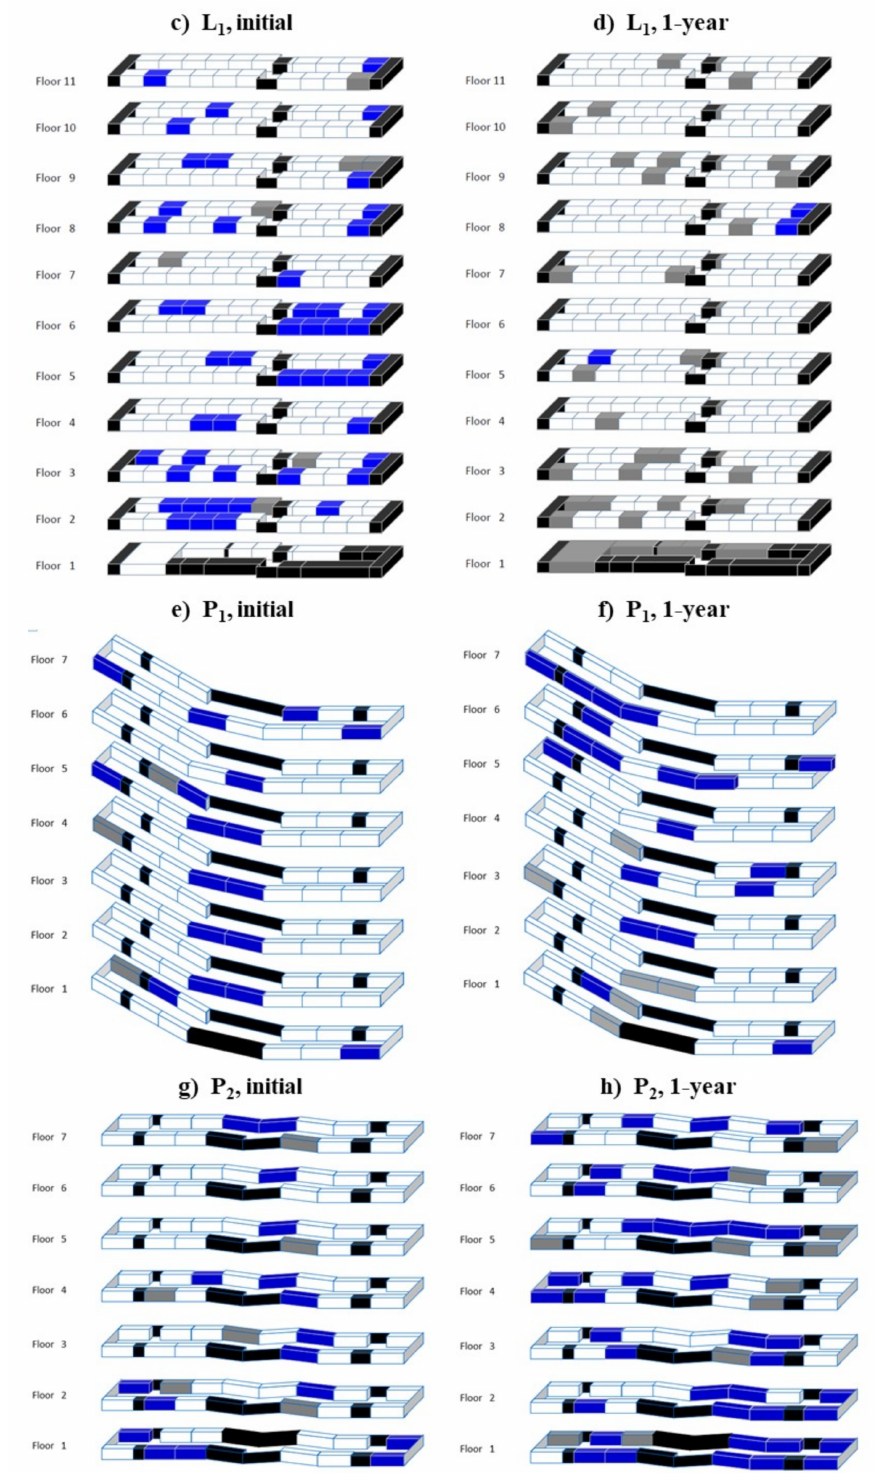
Figure 1. Representative map (not to scale) of the buildings monitored for house mouse activity. T 1 , L 1 , P 1 and P 2 represents buildings at Trenton, Linden, and two buildings at Paterson, respectively. Blue blocks indicate apartments with mouse activity. Black blocks indicate elevator, stairwell, or open space. Gray blocks indicate apartments where access was